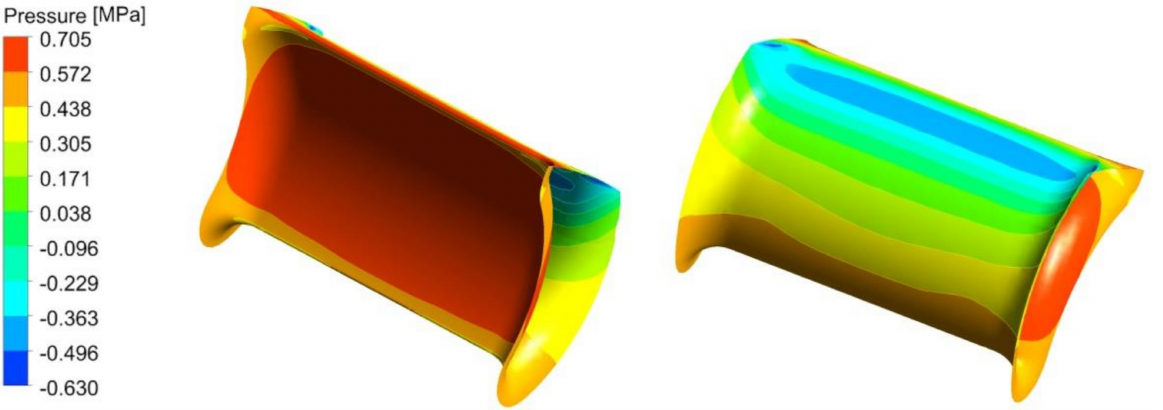
Figure 20. Pressure computed by computational fluid dynamic (CFD) 3D transient analysis.